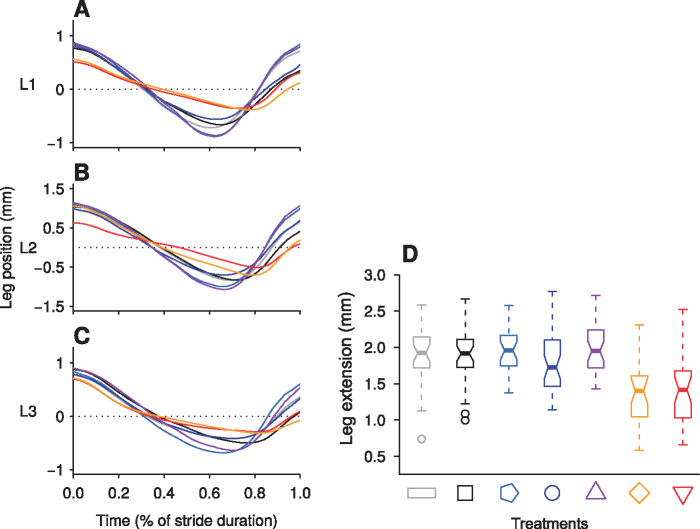
Leg kinematics and distance traveled in the ant frame. Leg trajectories during a stride for each treatment of the factorial design experiments for the front (A), the middle (B), and the hind (C) legs and the extension of legs in the ant frame (D). Time starts with the beginning of a stance and finishes with the end of the swing phase. In order to compare trajectories of the three pairs of legs, which have different positions in the antero-posterior axis, each trajectory is centered on its mean position during a stride. (D) Each boxplot includes the front, middle, and hind legs for all ants of the corresponding treatment. See Fig. 3 for the explanation of the symbols representing the different treatments.